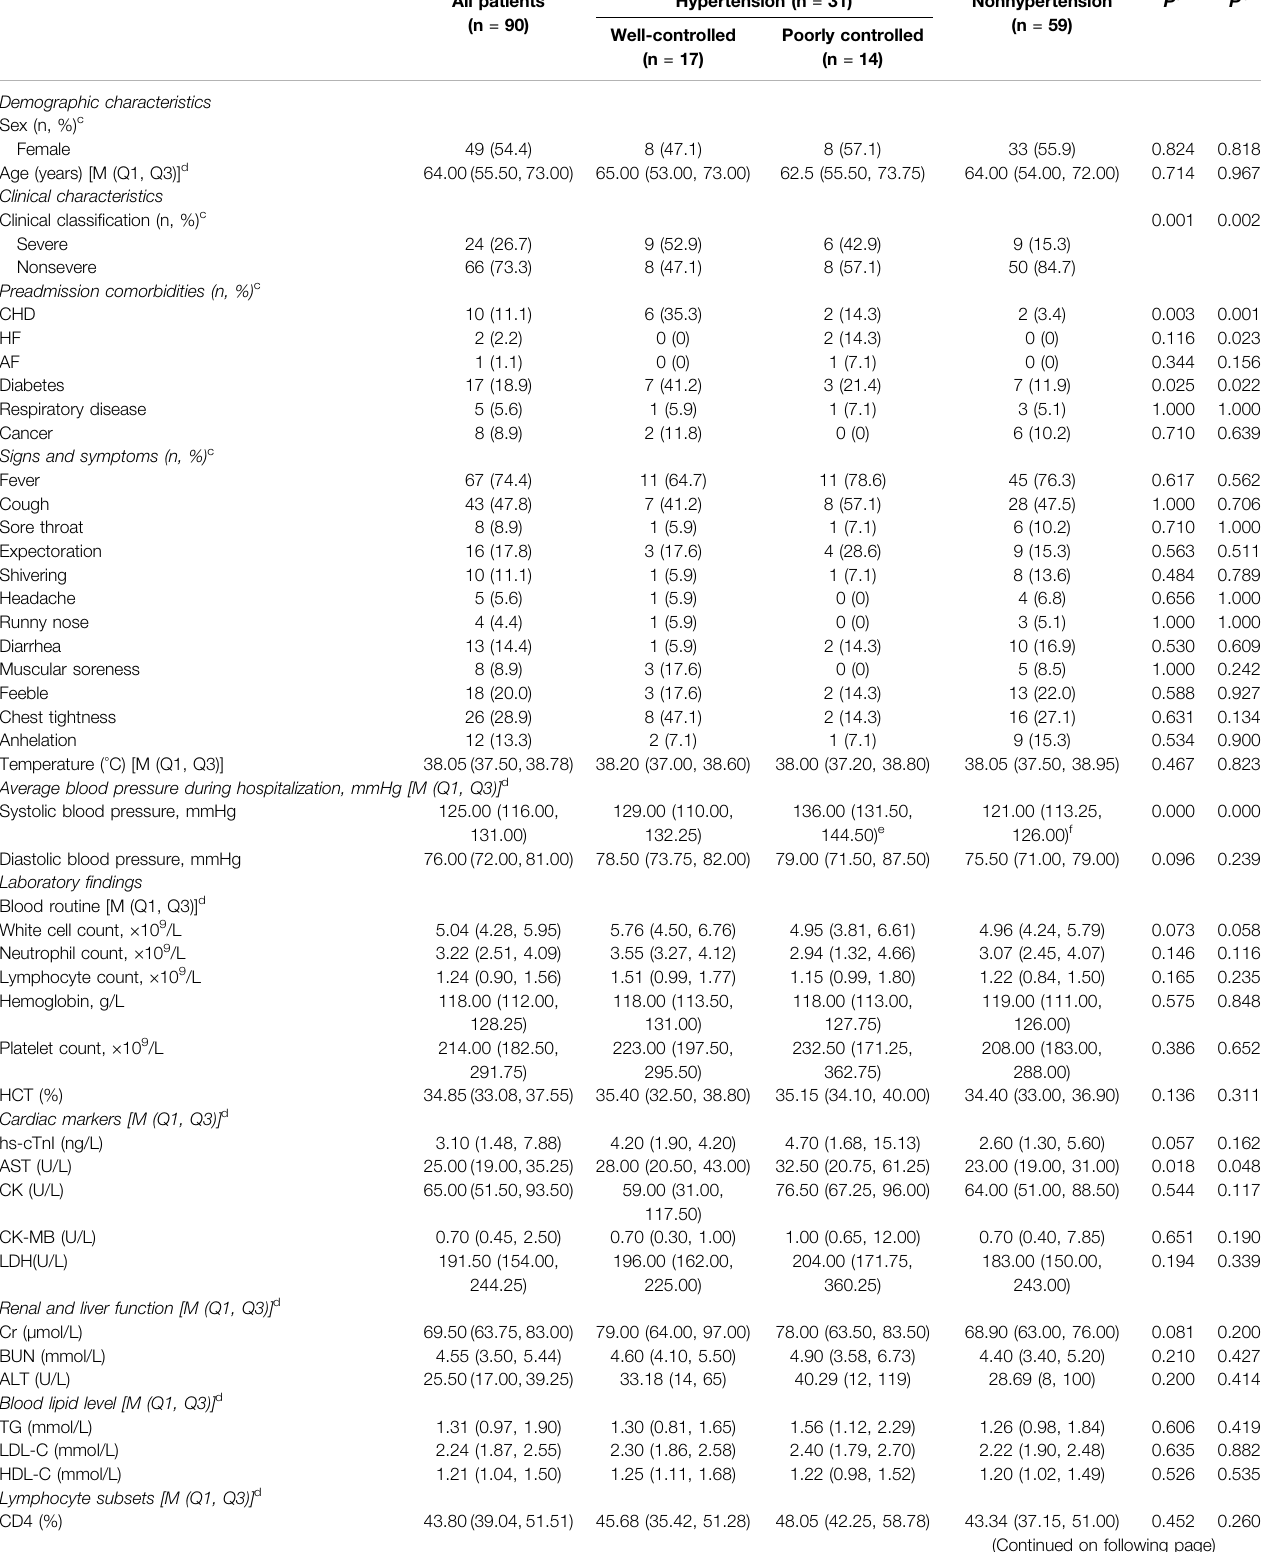
TABLE 1 | The comparison of demographic and clinical characteristics, laboratory and radiology fi ndings, clinical measures, clinical outcomes, and severity of COVID-19 among well-controlled, poorly controlled, and nonhypertension groups.